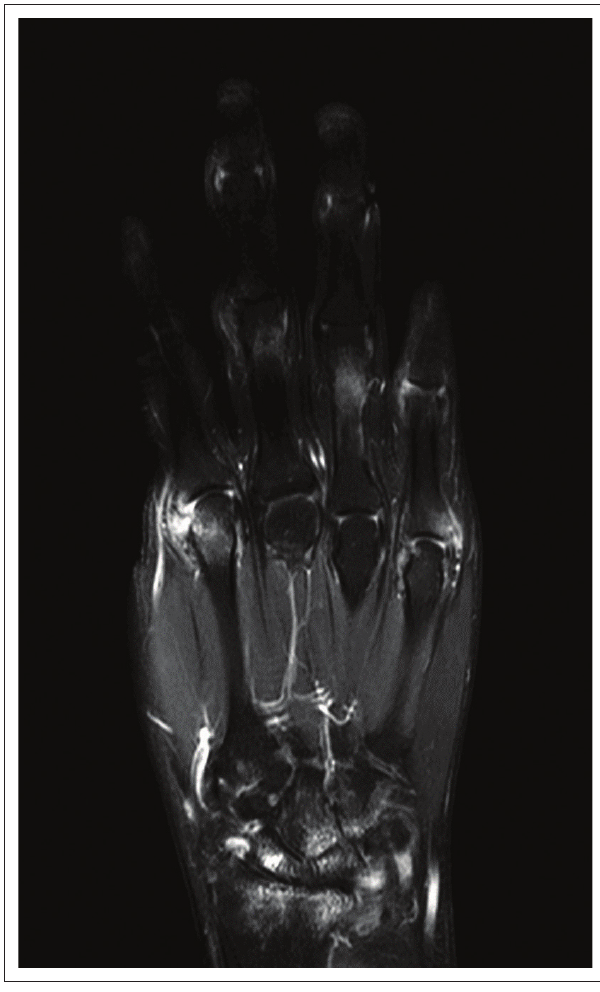
Note: this is the same patient in Figure 5 showing multiple areas of enhancement of the bones corresponding to the regions of bone oedema seen in Figure 7, and synovial enhancement in the second metacarpophalangeal joint. This supports active disease in this hand. FIGURE 8: Post-contrast fat-suppressed T1-weighted coronal magnetic resonance